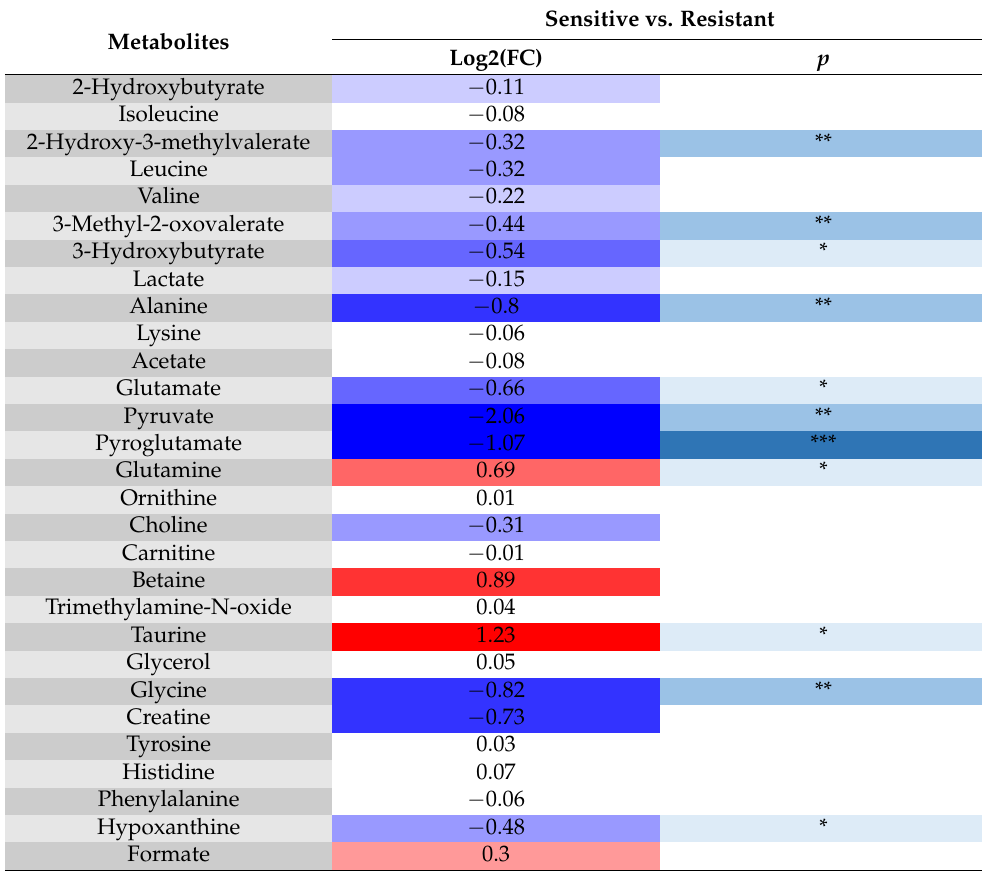
Table 2. Identified metabolites between the two groups by 1